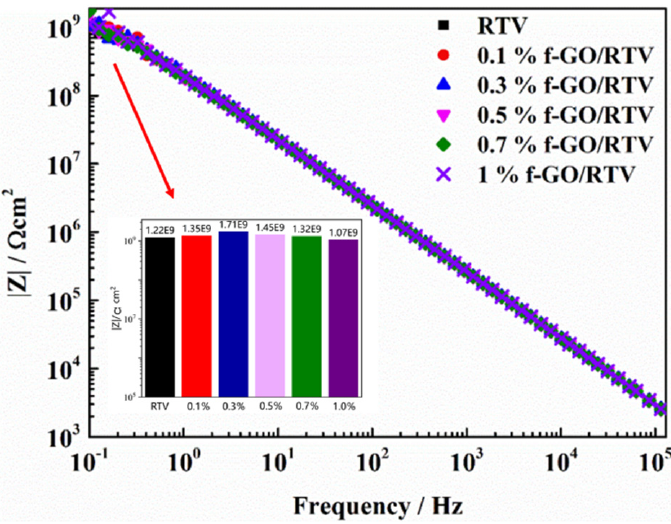
Figure 5. Impedance modulus value of f-GO/RTV silicone rubber nanocomposite coatings with